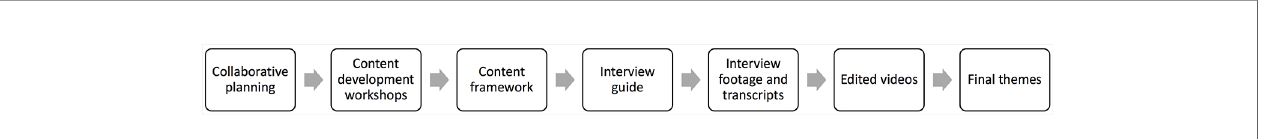
FIGURE 1 | Outline of the development